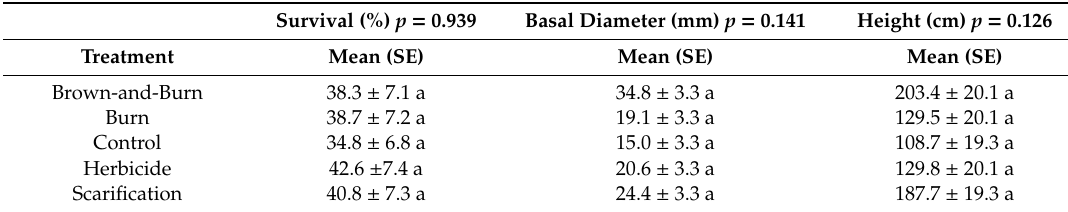
Table 2. Planted shortleaf pine seedling mean, standard error, and letter grouping results are presented for survival, basal diameter (mm), and height (cm) variables following four growing seasons for the five site preparation and release treatments in Morgan County, Tennessee, USA. Treatment means followed by the same letter in a column indicate no significant di ff erences ( p = 0.05). Survival (%) p =